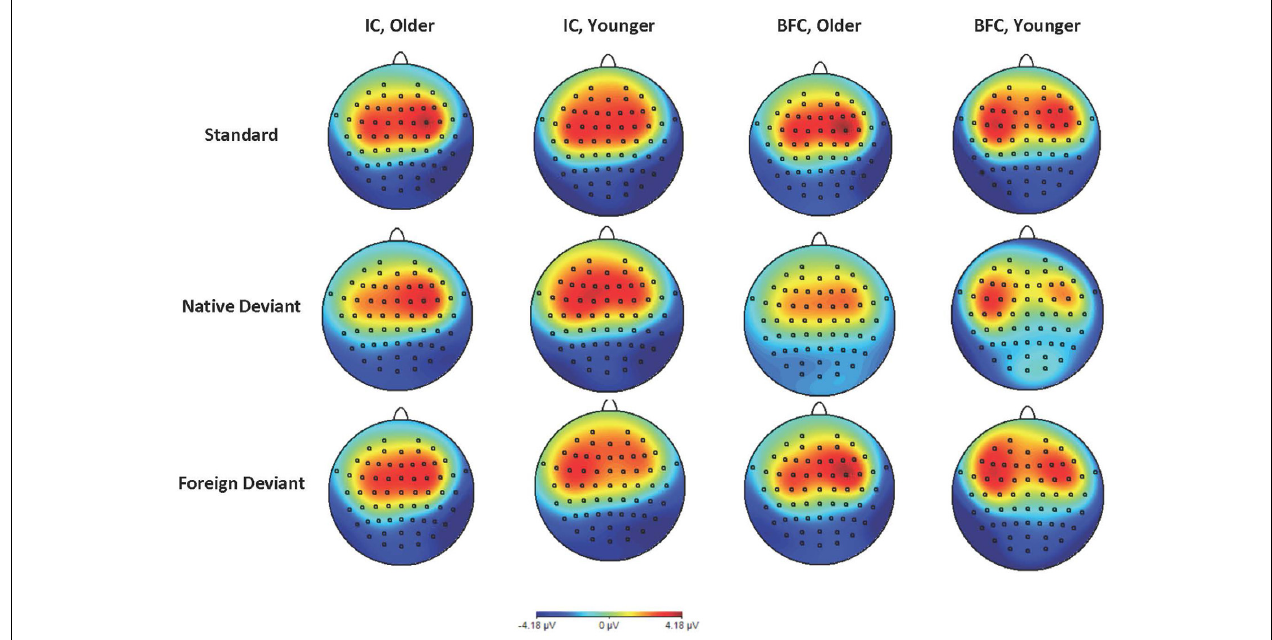
FIGURE 2 | Topographic maps of ERP in the time window of 100 ms–200 ms in the younger and older groups of participants—biological family (BFC) and children raised in institutional settings (IC) in response to three types of stimuli: Foreign Deviant, Native Deviant, and